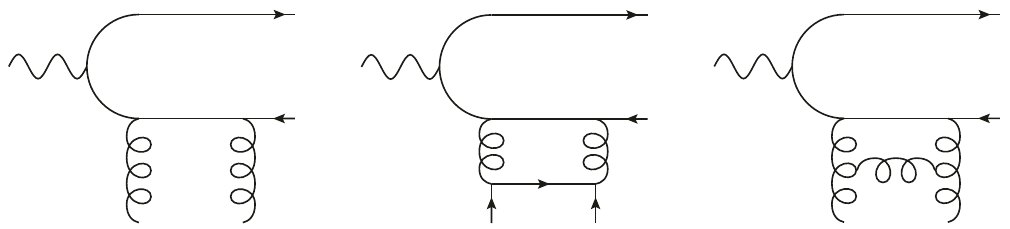
Figure 3 . From left to right: LO gluon, NLO quark and NLO gluon initiated subprocess Feynman